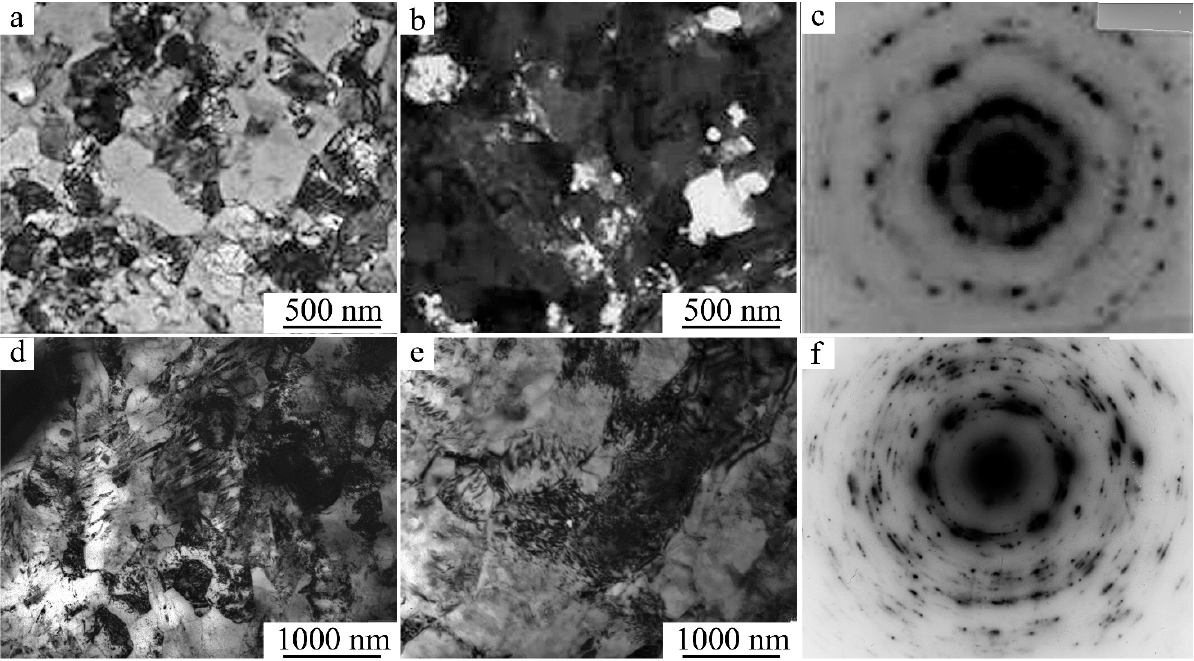
Figure 11. ( a , d , e ) Bright- and ( b ) dark-field TEM images of the microstructure, and ( c , f ) the corresponding SAED patterns, of the UFG Ti 49.4 Ni 50.6 alloy after ECAP and straining to 40%. ( a , b ) TEM and ( c–f ) SAED patterns (SD 0.3 µm) for ( a – c ) the transverse and ( d – f ) the longitudinal cross sections [73].